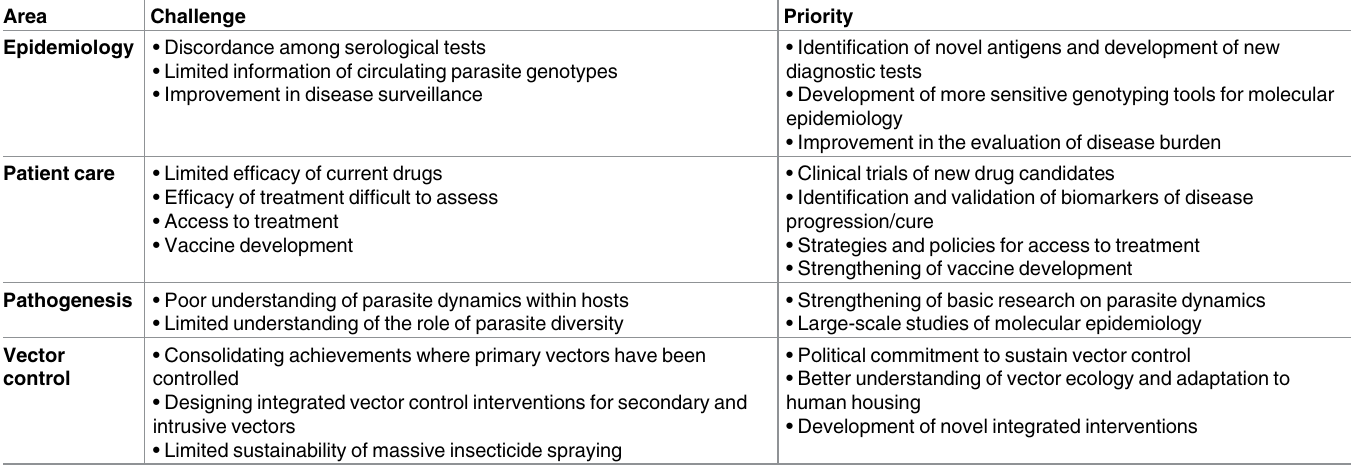
Table 1. Challenges and researchpriorities for Chagas